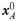
Analytic, but approximated, solution.Top: original image xA0. Central row: extreme images (MAD best and worst -left and right-) with the same RMSE than the white-noise corrupted image at the center. Extreme images are built from the eigenvectors of the metric matrix, M(xA0)=∇xS(xA0)⊤·∇xS(xA0) (hence requiring Result I). In this case no search is carried out: the image corrupted with white noise in the center of 2nd row is there only for comparison purposes. The fact that the extreme images are visually better and worse than the central image indicates that the theory works. Bottom row: isolated distortions of the same energy: Δx0=xA0-xMAD0 versus white noise.